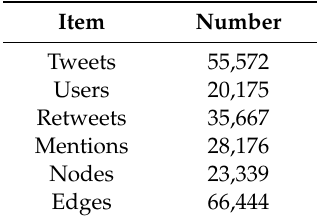
Table 1. Information about the